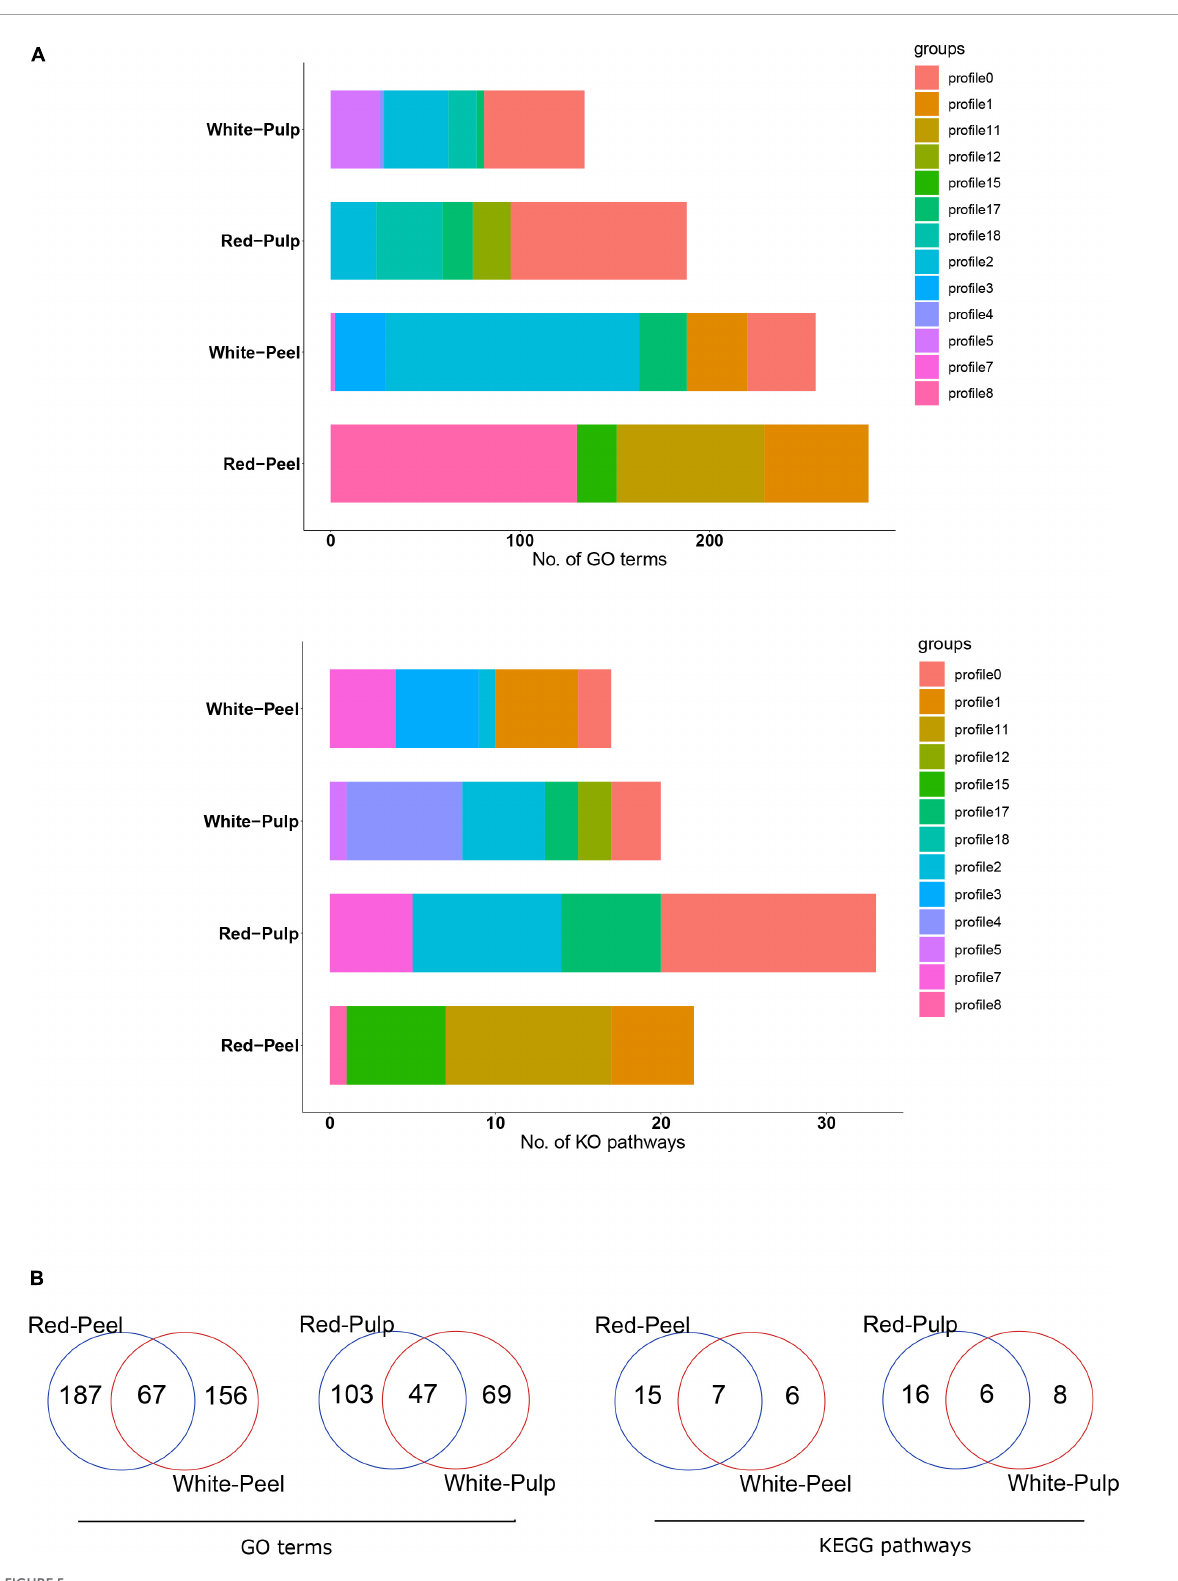
Frontiers in Plant